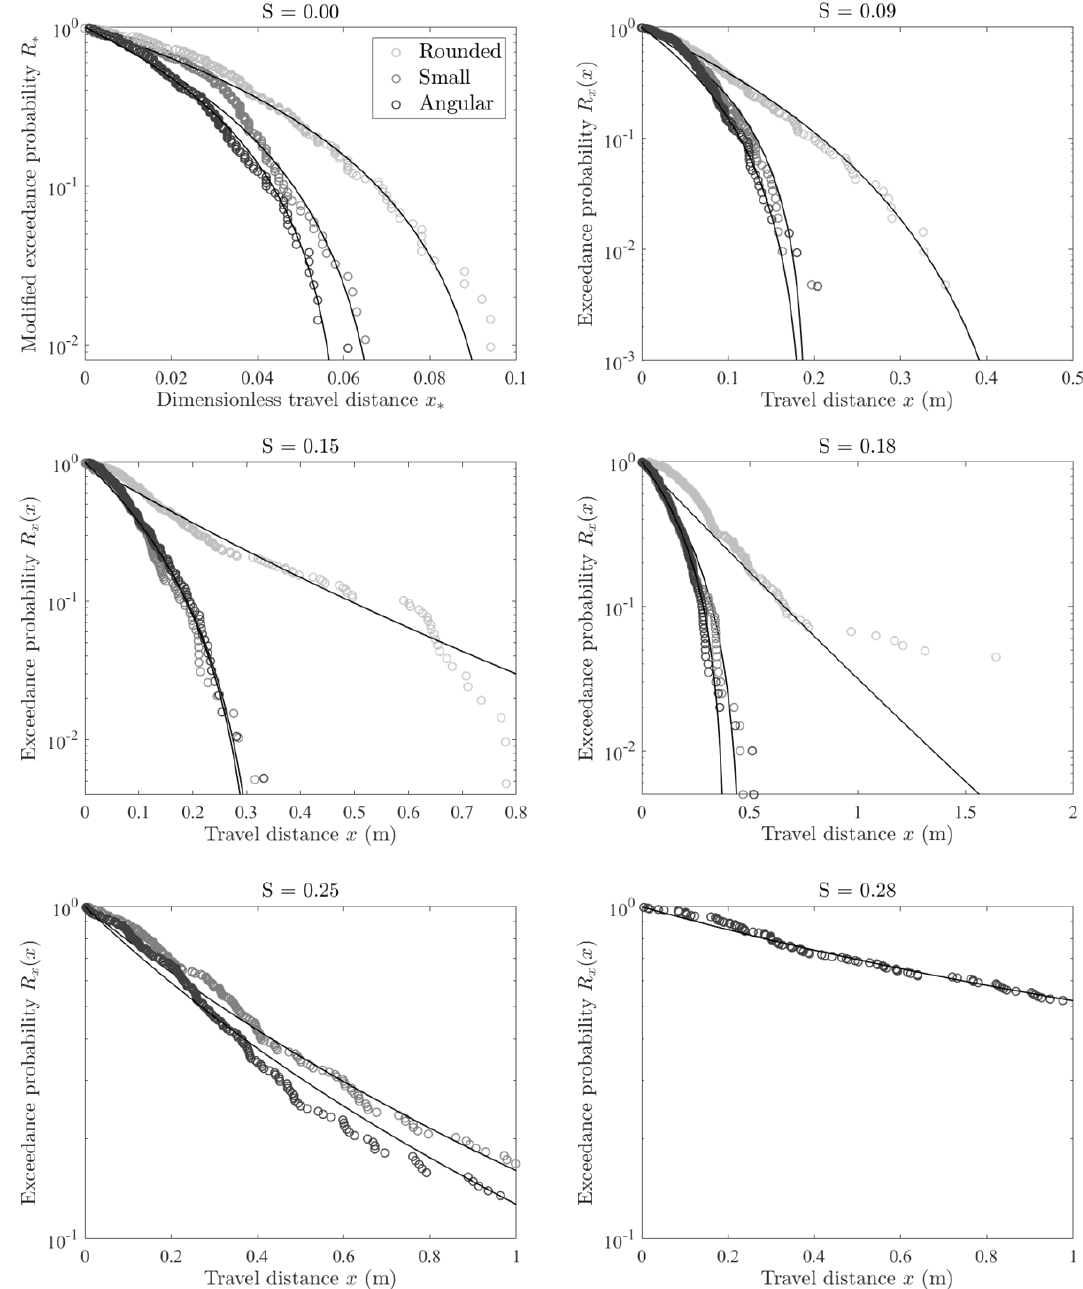
Figure 7. Plots of exceedance probabilities versus downslope travel distance for experiments over six values of slope S . Natural angular (dark gray), natural small (medium gray), and natural rounded (light gray) particles are shown together fitted with generalized Pareto distributions of varying A and B parameters. The concavity of these semi-log plots indicated whether particles are being heated (positive concavity) or cooled (negative concavity). All particles experience rapid thermal collapse on low slopes 0.00 and 0.09 and then transition to heavy-tailed distributions indicating net heating for slopes 0.25 and greater. Rounded particles travel further downslope before becoming disentrained compared to angular and small particles due to the decreased relative effectiveness of collisional friction. On slopes greater than 0.18, rounded particles do not come to rest on the roughened experimental hillslope